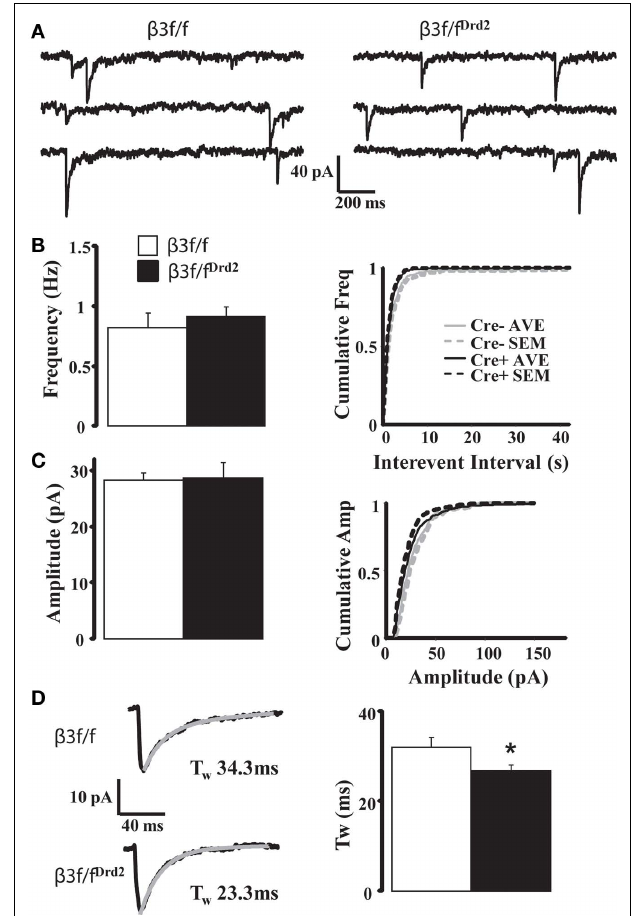
FIGURE 4 | Synaptic decay is altered in MSNs from conditional KO mice. (A) Representative mIPSC traces from β 3f/f and β 3f/f Drd2 mice. (B,C) Summary mIPSC frequency and amplitude graphs (left) and averaged cumulative distribution plots for all cells (right) in β 3f/f and β 3f/f Drd2 mice. (D) Representative individual mIPSCs (left) with double exponential decay fittings in gray from β 3f/f and β 3f/f Drd2 mice. Summary of decay fittings, right. Data derive from 16 to 17 cells from at least three mice in each